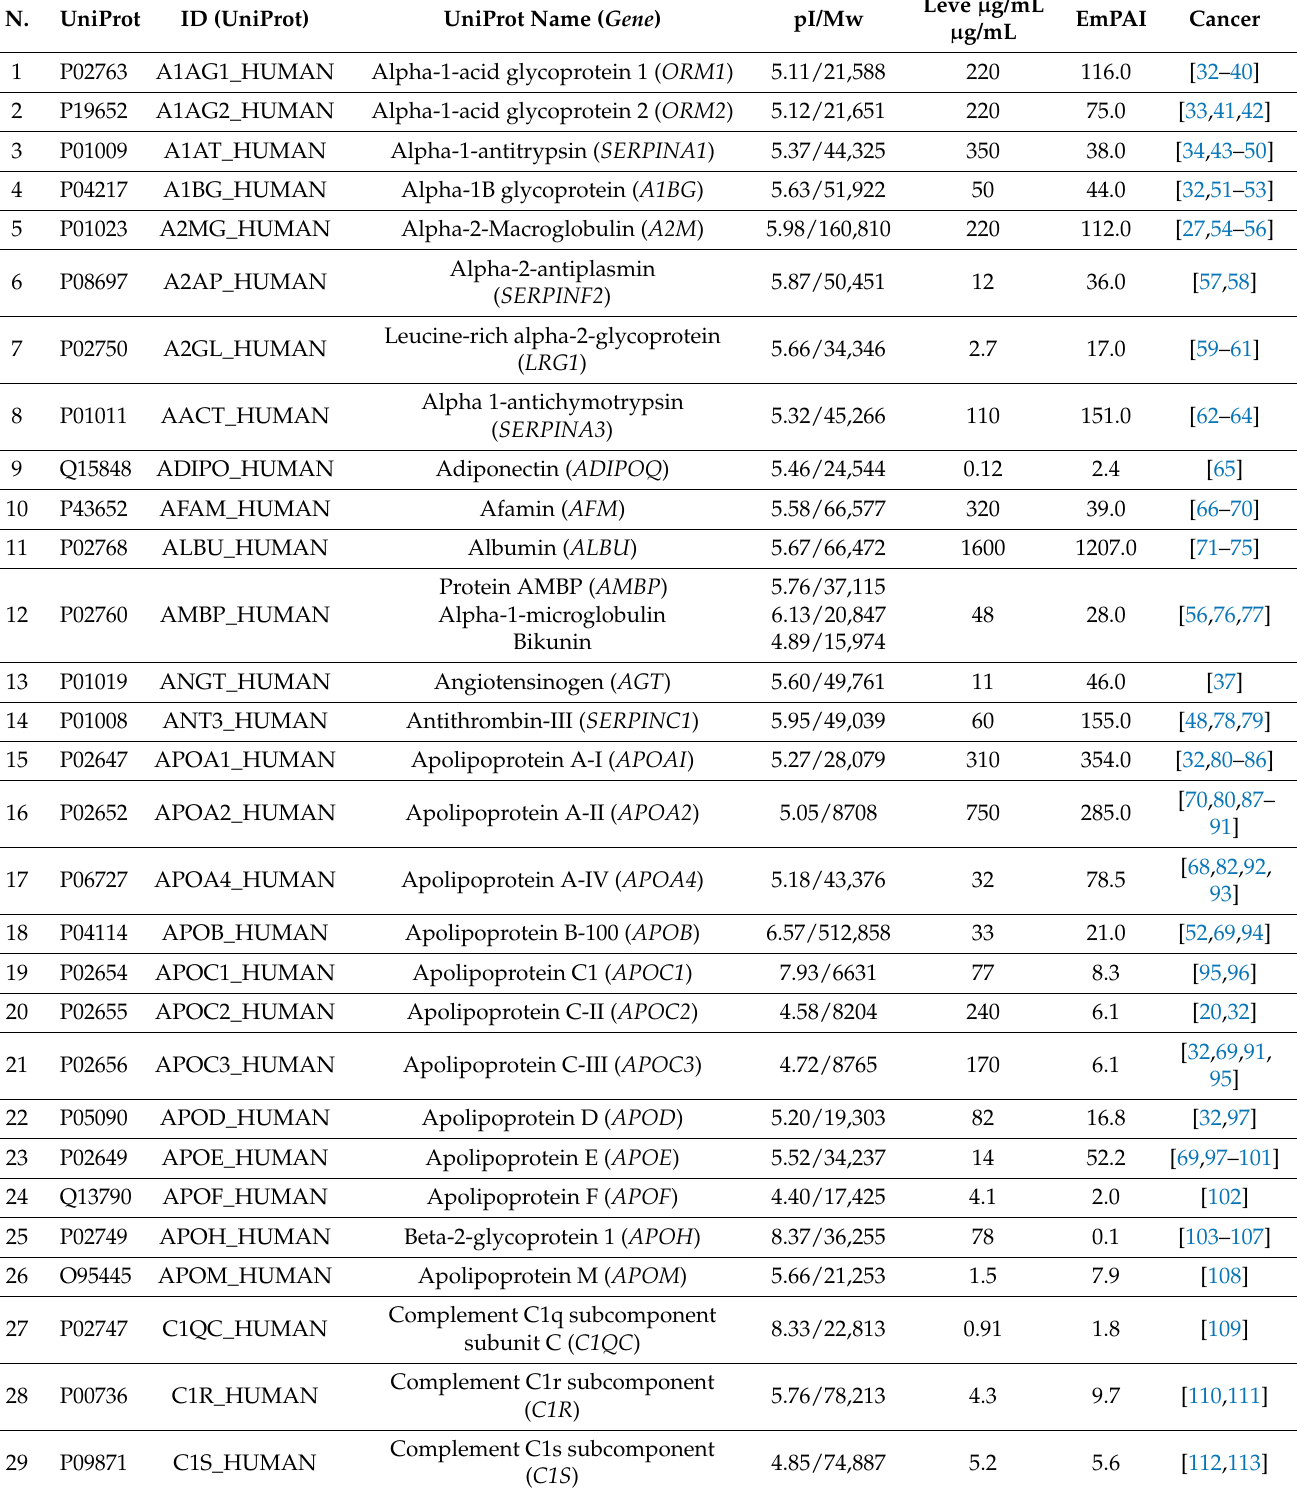
Table 1. The most abundant plasma proteins related to cancer. Concentration ( µ g/mL) is presented according to [16] if otherwise not shown. Abundance (emPAI) was calculated according to data from the semi-virtual 2DE (Supplementary Table S1). In the column “Cancer”, the references for cancer-related data are shown (the details are in the Supplementary